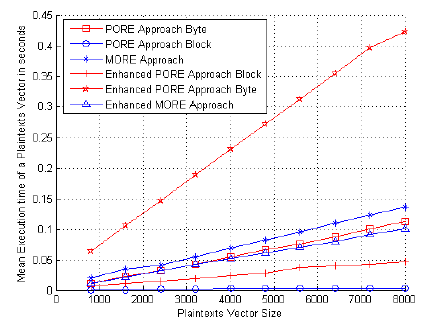
Figure 8: Execution